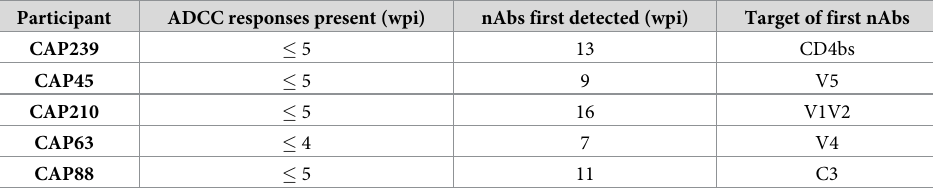
Table 1. Characterisation of autologous ADCC and nAb responses in five CAPRISA 002 participants.